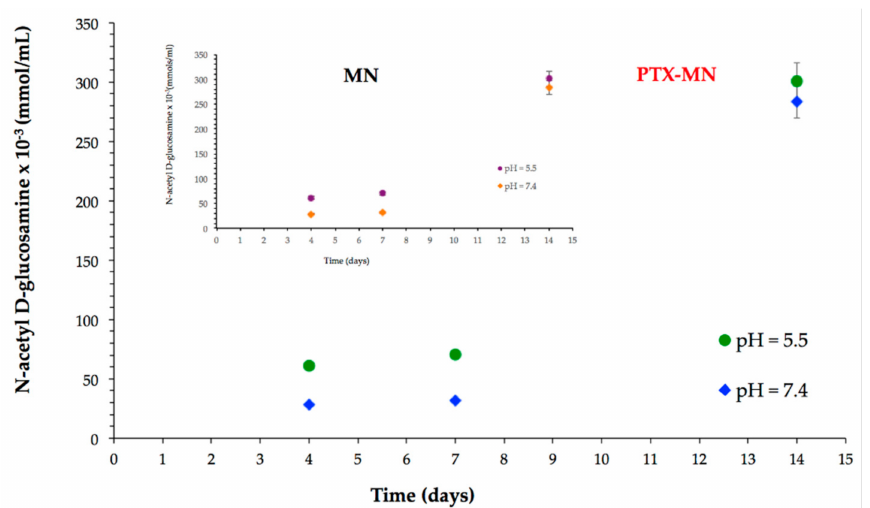
Figure 9. Biodegradation data of PTX-MN and